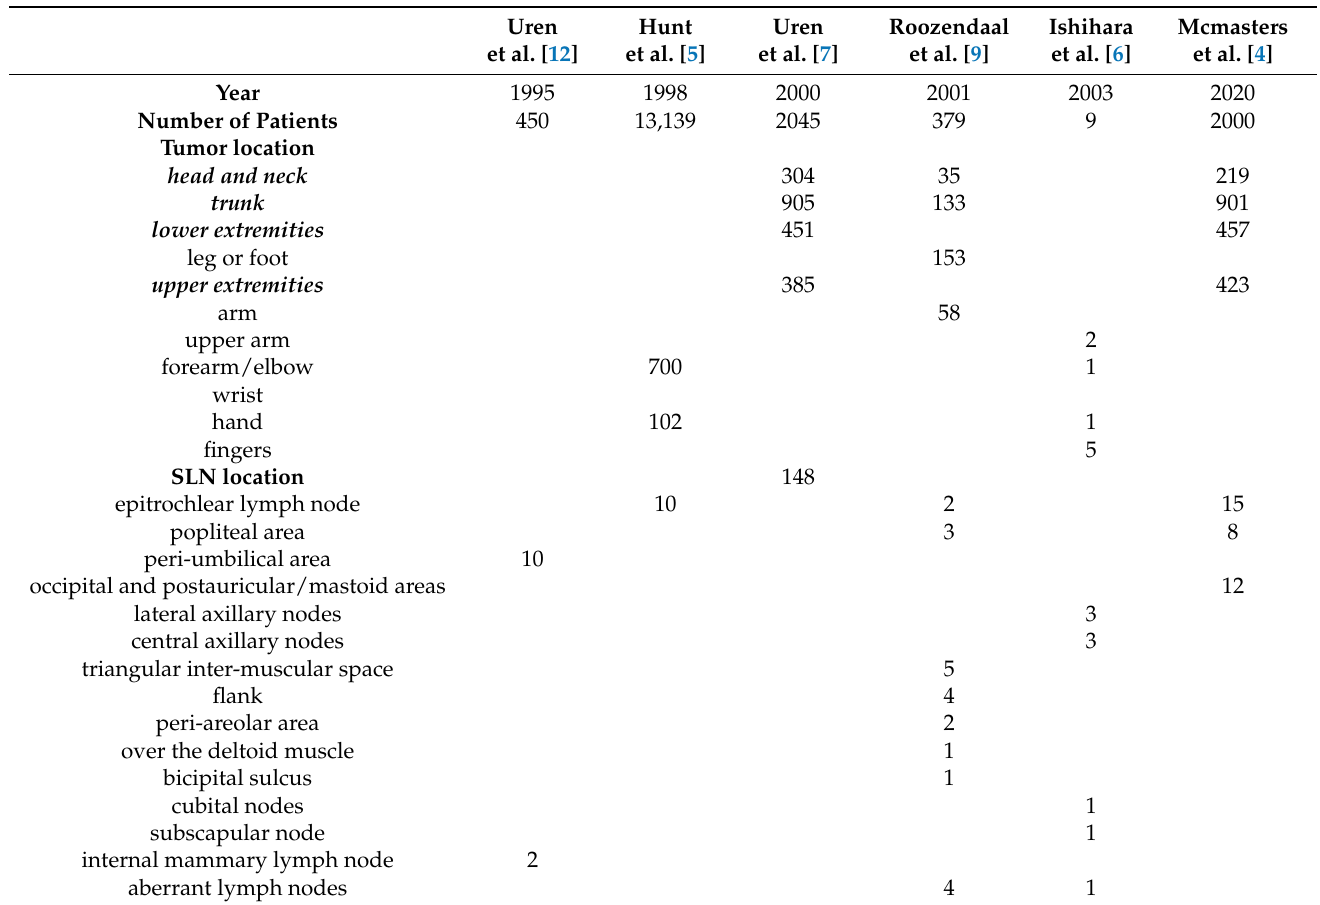
Table 1. Assessed studies: number of patients; tumor locations; SNL